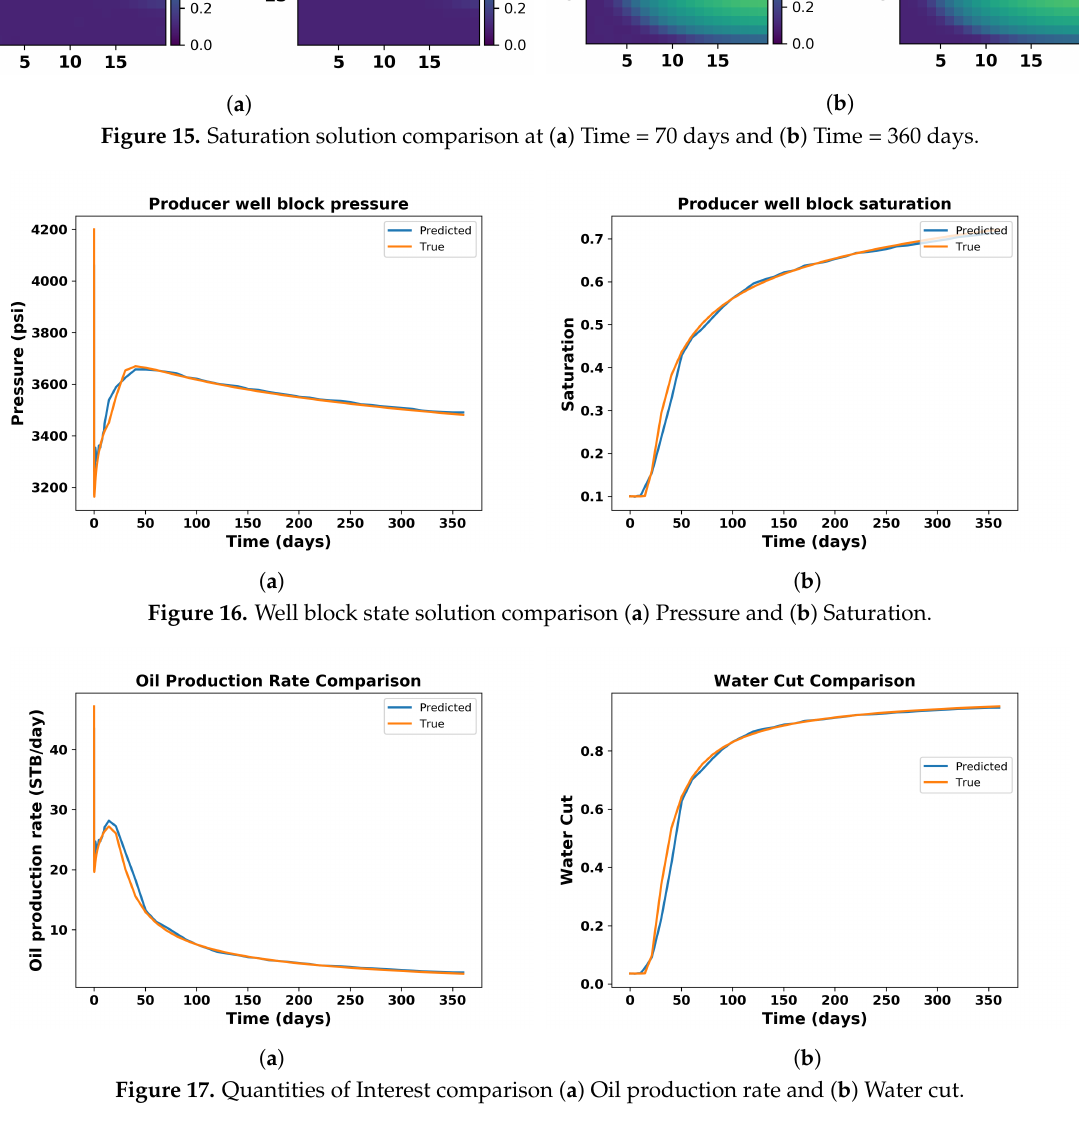
Figure 17. Quantities of Interest comparison ( a ) Oil production rate and ( b ) Water